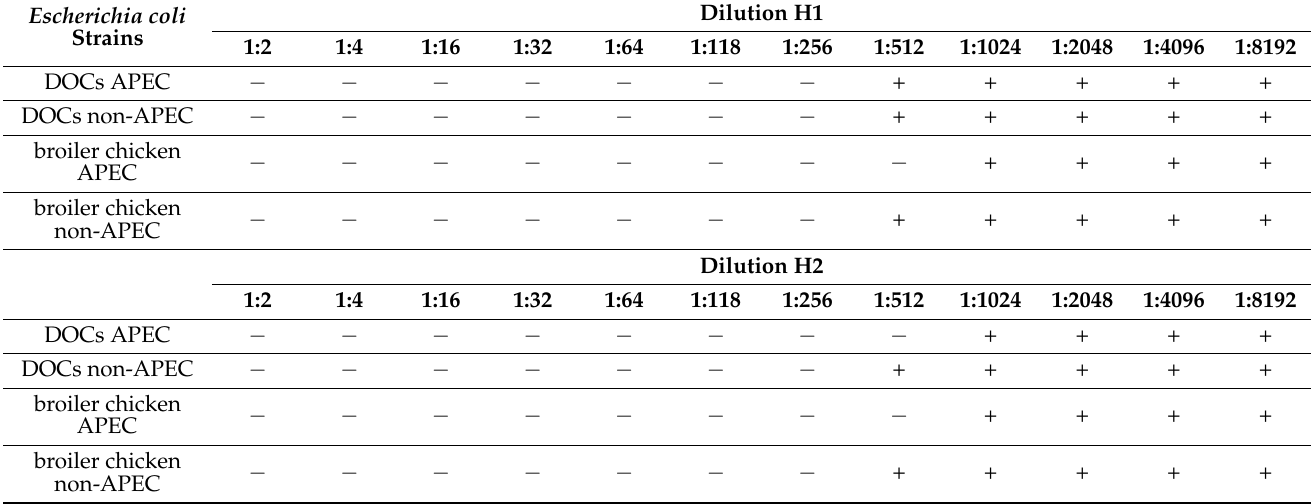
Table 3. MIC of analyzed